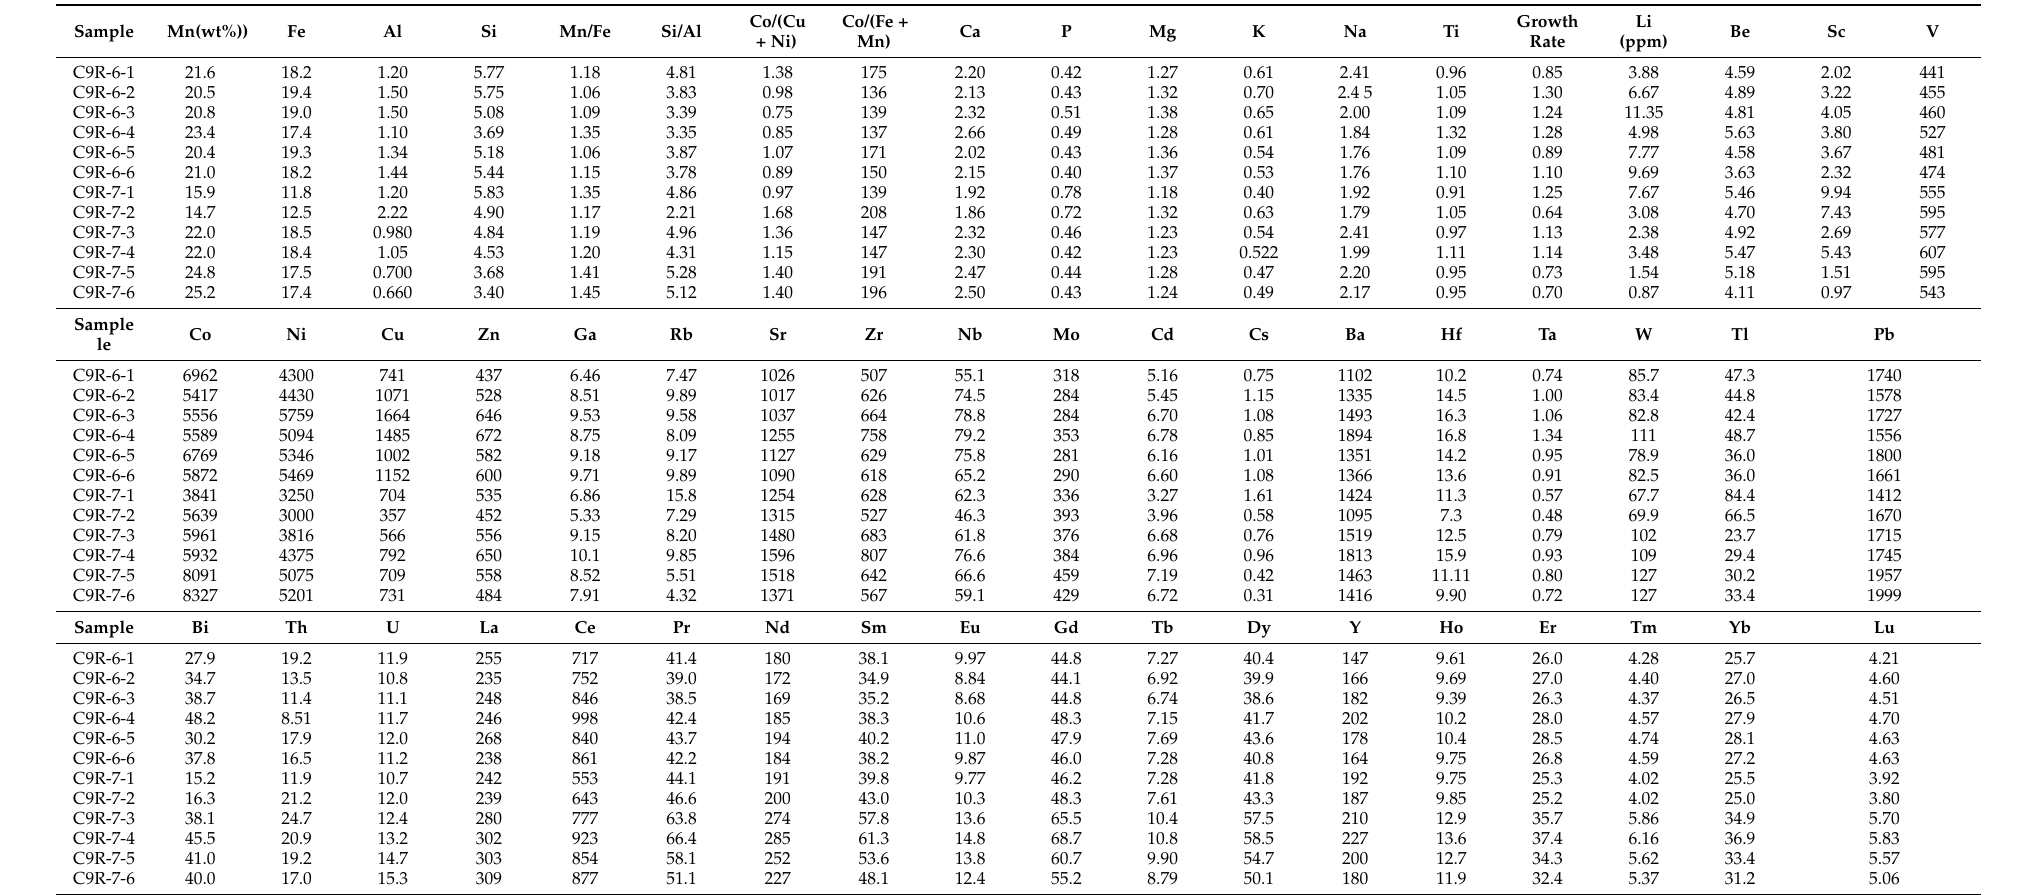
Table 2. Geochemistry compositions of the ferromanganese